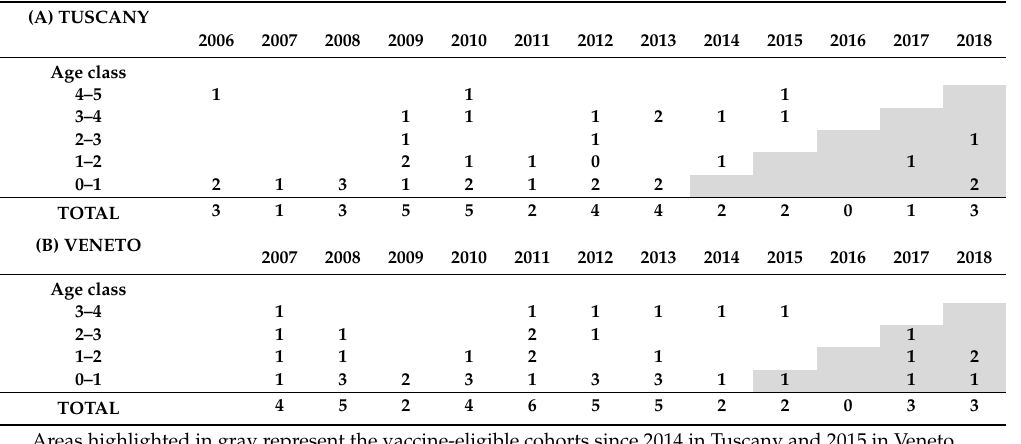
Table 2. Distribution of Neisseria meningitidis B cases based on age groups and year of diagnosis in Tuscany (2006–2018) and Veneto